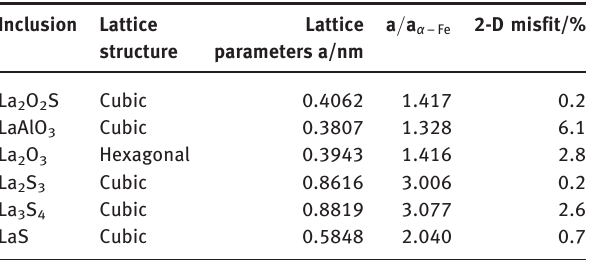
Table 3: The lattice mismatch between La inclusion and the α -Fe at